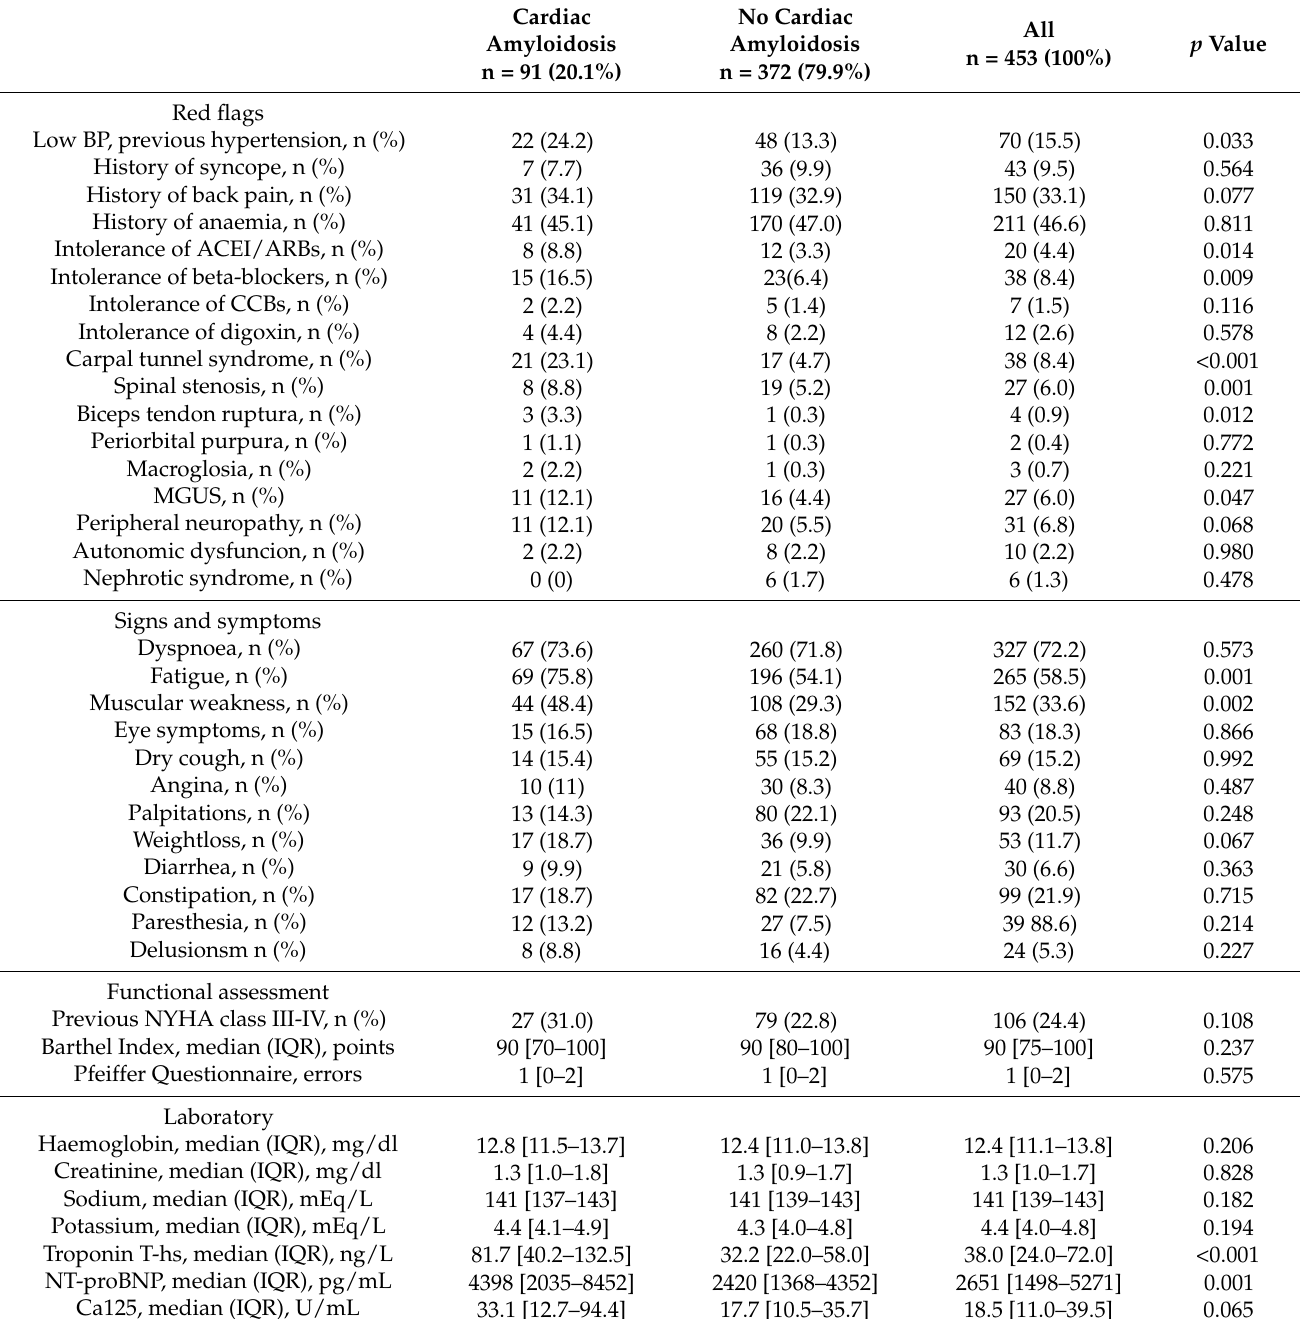
Table 1. Cont . Table 1. Baseline characteristics of the population. Table 1. Baseline characteristics of the population. Table 1. Baseline characteristics of the population. Table 1. Baseline characteristics of the population.